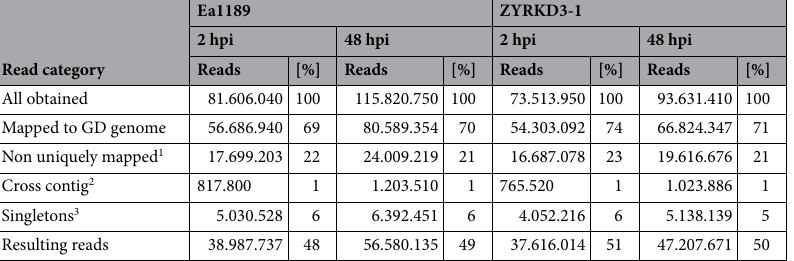
Table 1. Mapping of RNA-seq data. The transcriptome of Mr5 was sequenced at 2 and 48 hpi with the wild type strain Ea1189 and the avrRpt2 EA deletion mutant strain ZYRKD3-1. Numbers of reads per sample received from RNA-seq after sequencing and mapping with BWA were shown in total and percentage of all obtained reads. 1 Number of reads mapped to more than one site of the genome, such reads were excluded from analysis. 2 Number of reads with the other end mapped to a different contig. 3 Number of reads with itself or its mate